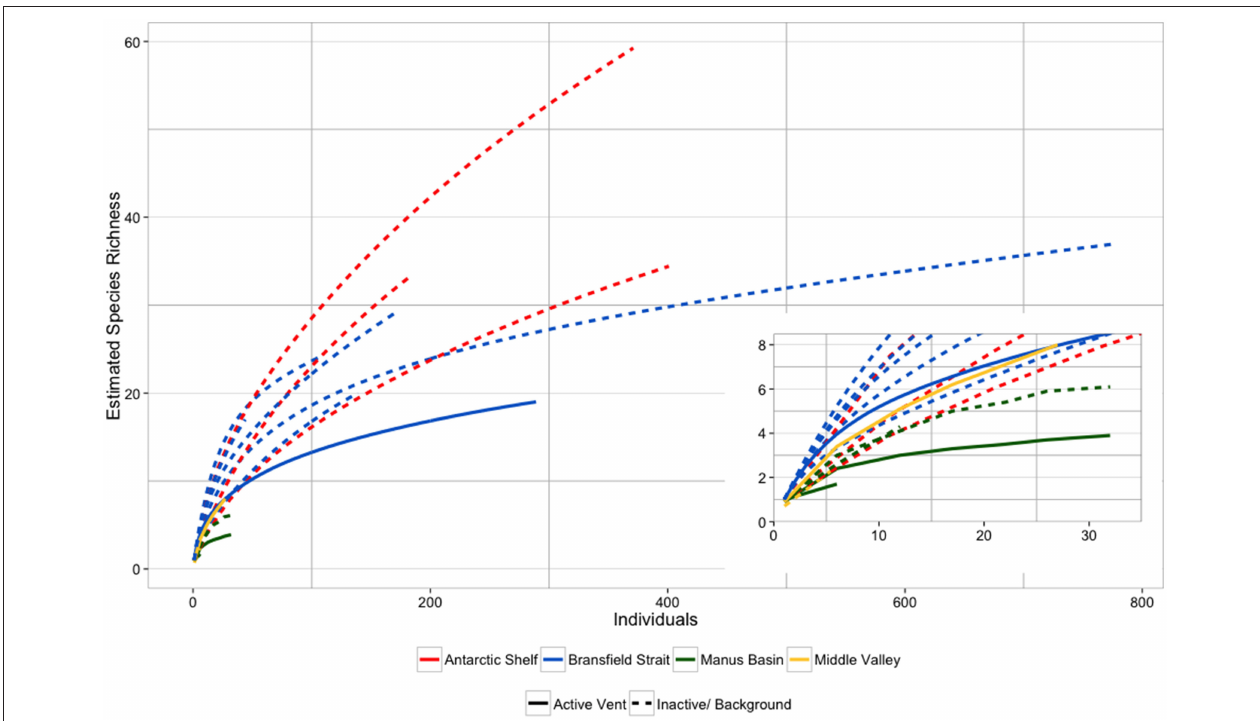
FIGURE 6 | Comparative individual-based species accumulation curves between Bransfield Strait sites (this study) and literature values for other diffuse hydrothermal vents (Grassle et al., 1985; Levin et al., 2009) and typical bathyal sediments of the West Antarctic Peninsula (Neal et al., 2011). Data from the West Antarctic Peninsula are for polychaete species richness